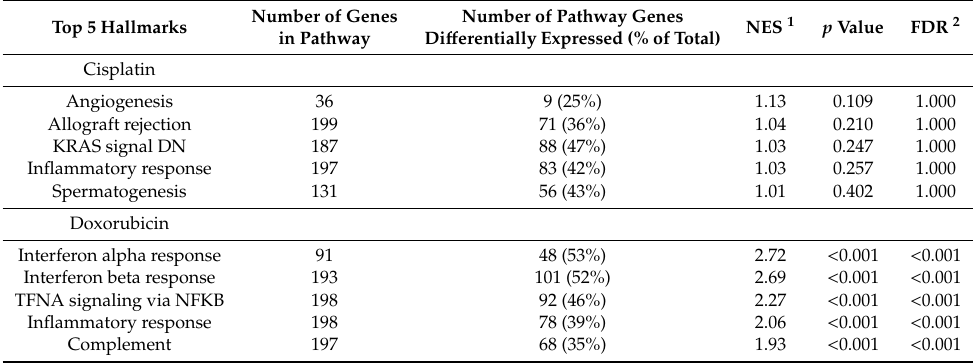
Table 1. The gene set enrichment analysis (GSEA) for cancer hallmarks enriched in cisplatin- and doxorubicin-treated HeLa cells.